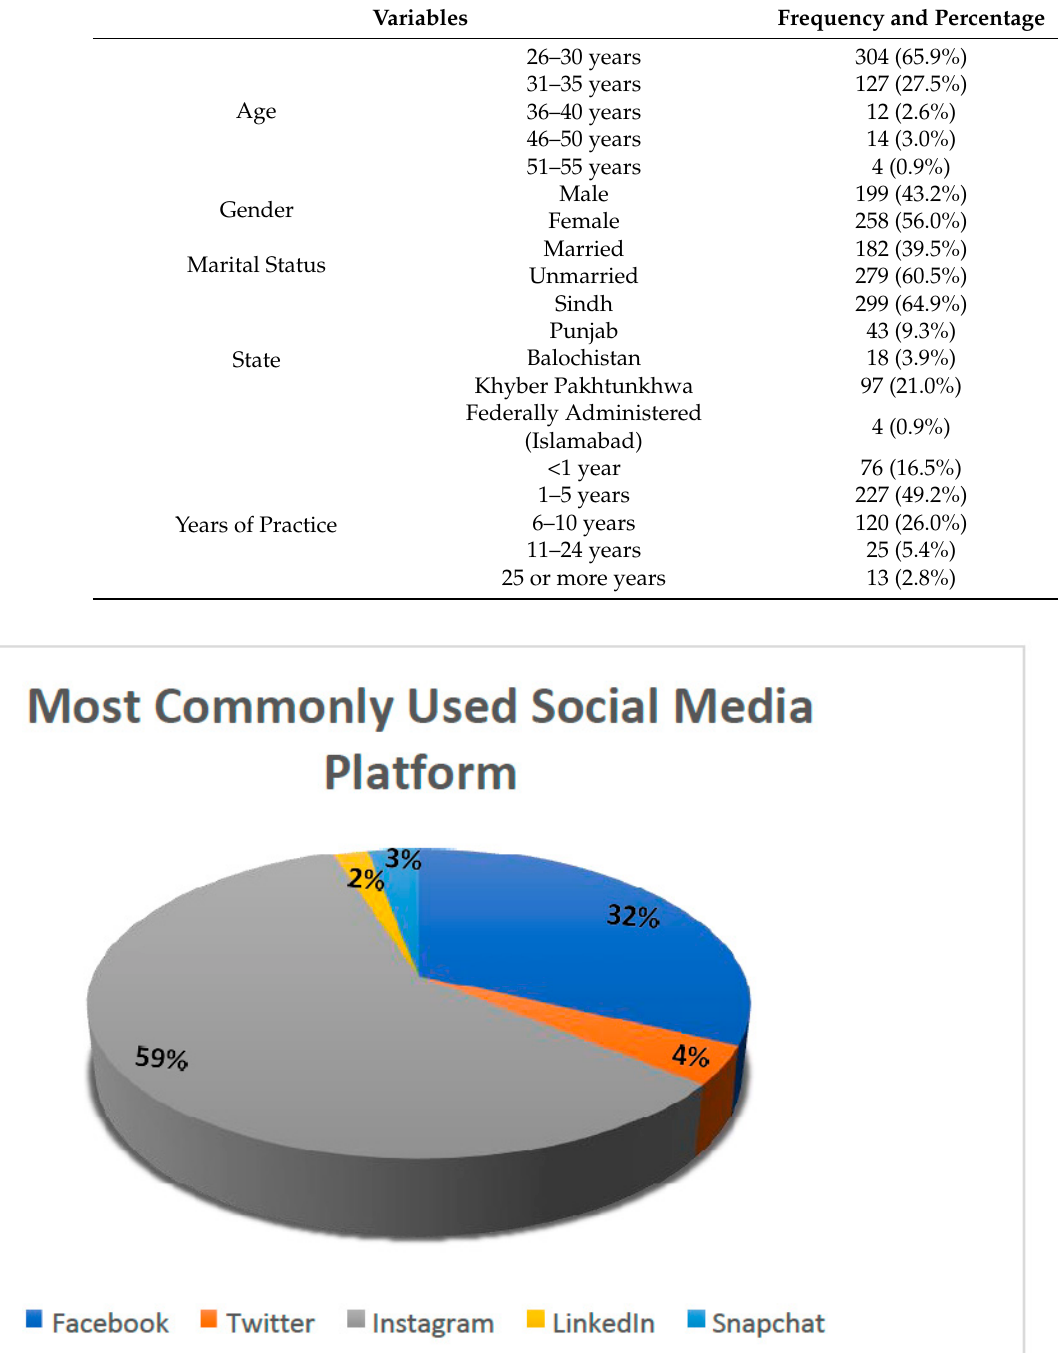
Table 1. Distribution of demographic details of the participant ( n = 461).